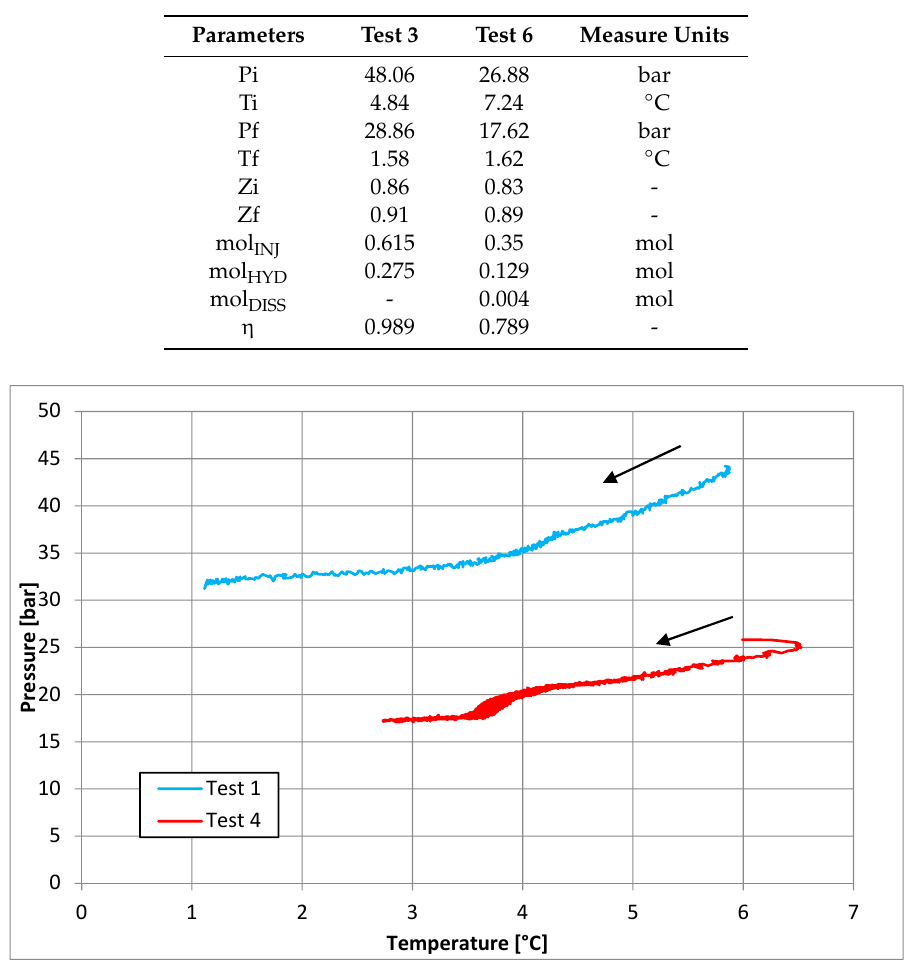
Table 3. Parameters related to Test 3 (with CH 4 ) and Test 6 (with CO 2 ).